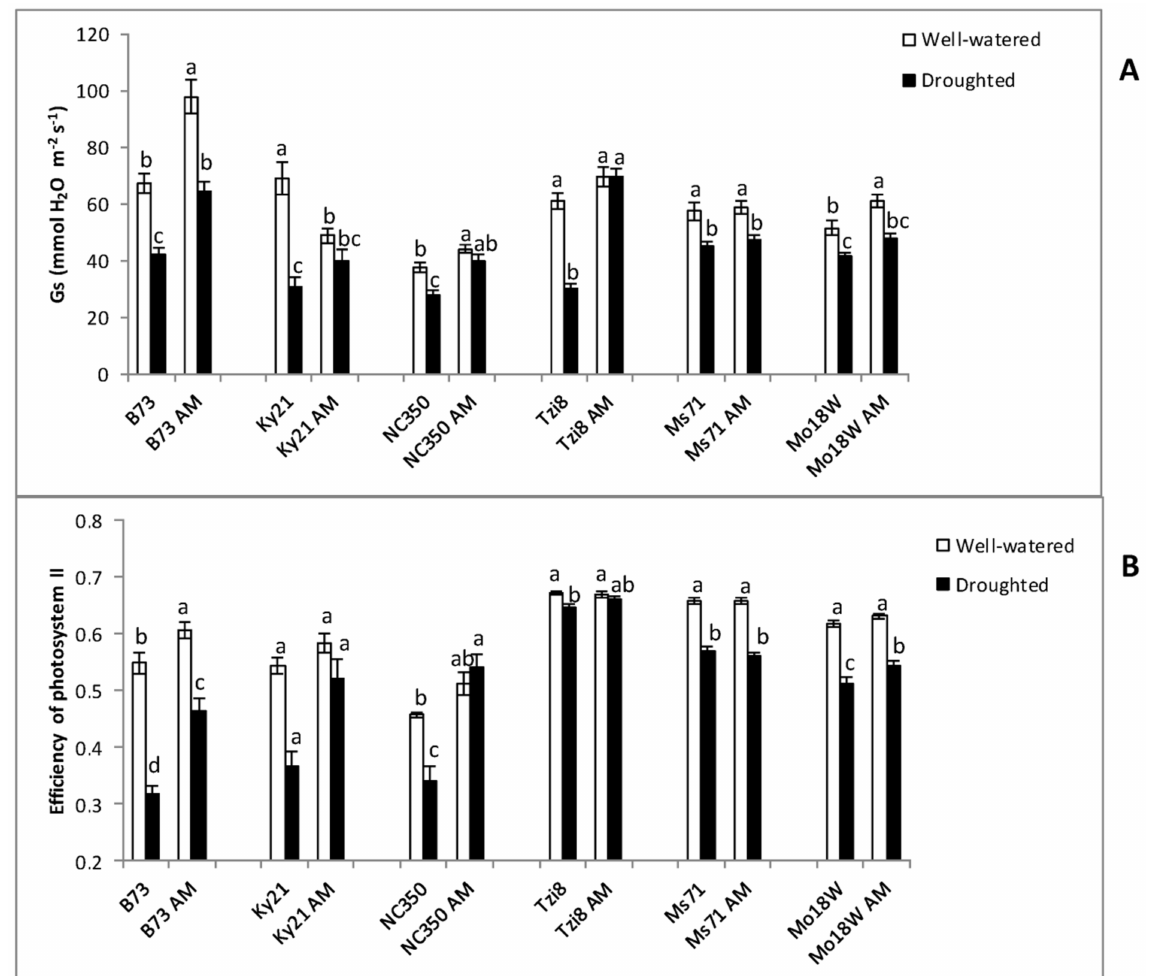
Figure 7. ( A ) Stomatal conductance (Gs) and ( B ) photosystem II efficiency in the light-adapted state ( ∆ Fv/Fm’) in six maize NAM lines (B73, Ky21, NC350, Tzi8, Ms71 and Mo18W) inoculated or not with an arbuscular mycorrhizal (AM) fungus. Plants were cultivated under well-watered conditions or subjected to drought stress. Data represents the means of 10 values ± S.E. Within each maize line, different letters indicate significant differences between treatments ( p < 0.05) based on Duncan’s